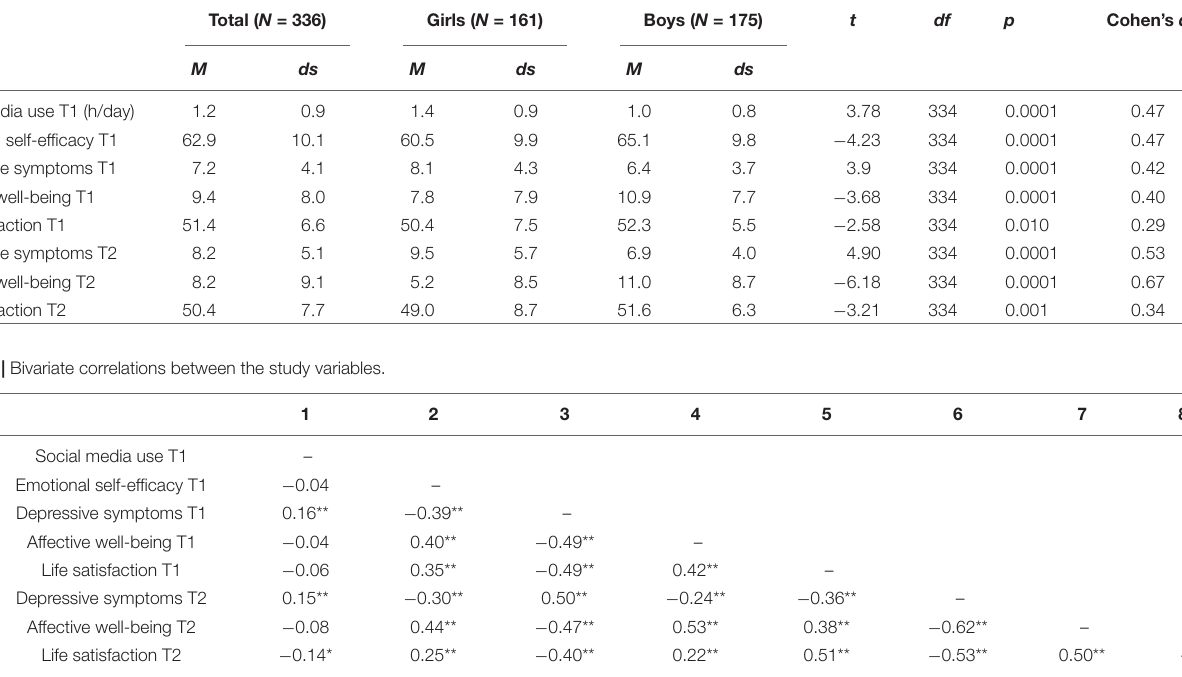
TABLE 1 | Descriptive statistics of the study variables in the total group of participants and by gender in the two waves (T1 and T2) ( N = 336).